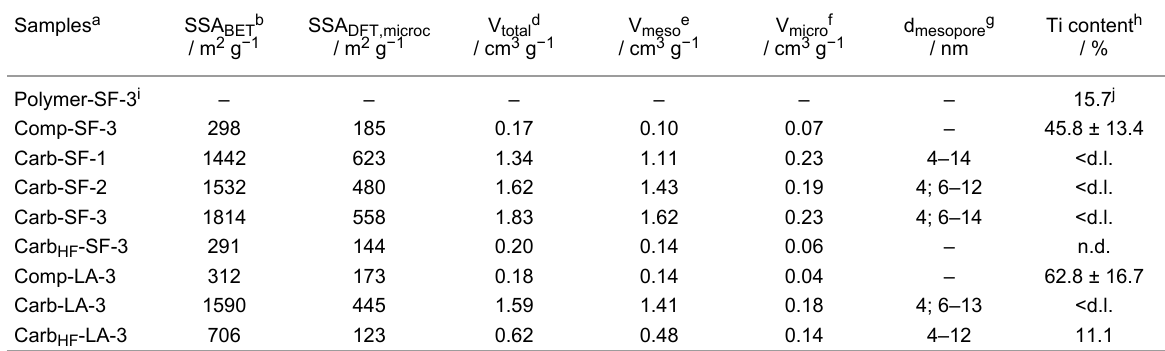
Table 1: Porosity and composition data summary for the different samples. Samples a